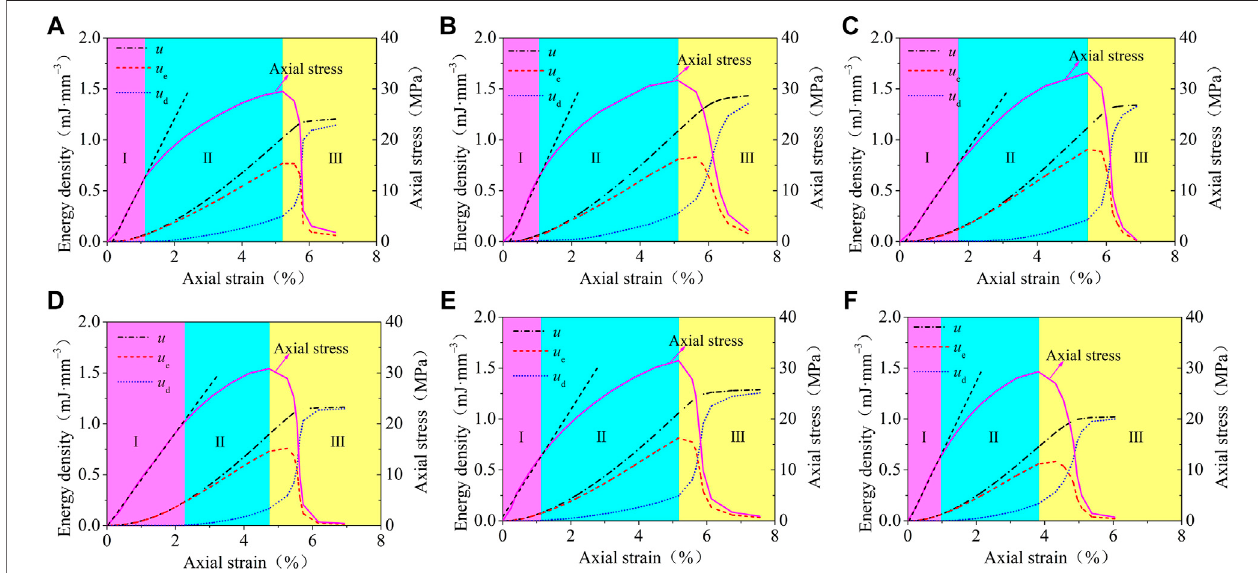
FIGURE4| Stress-straincurveofsaltrockandthevariationlawofenergyunderdifferentloadingrates: (A) u =0.25 MPa · min − 1 , (B) u =1.00 MPa · min − 1 , (C) u =1.50 MPa · min − 1 ,